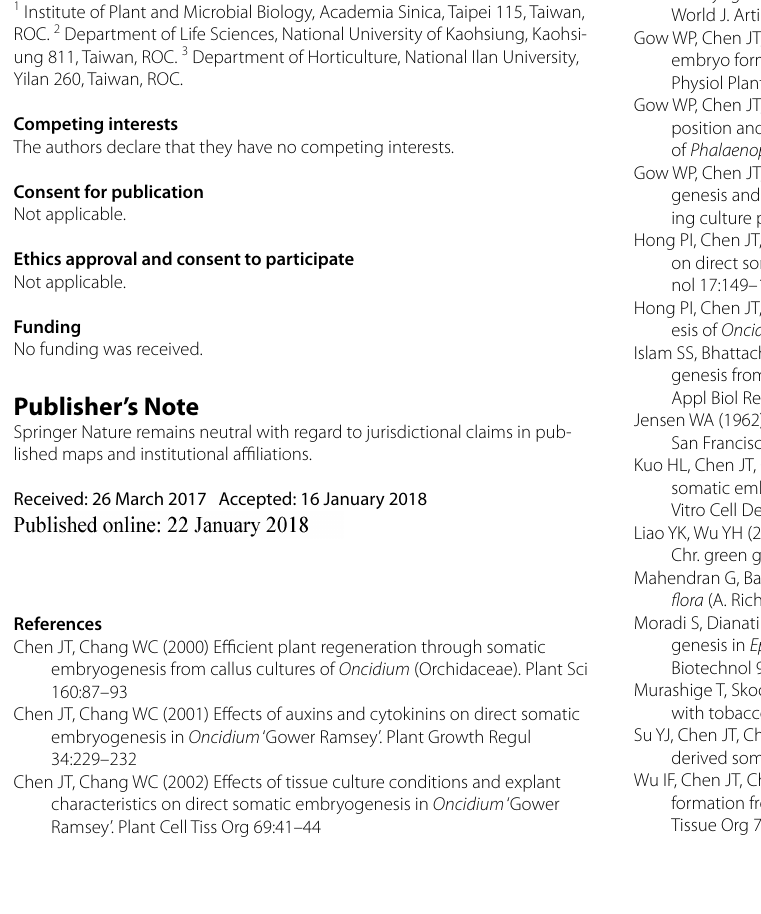
0.05 (Duncan 1955)